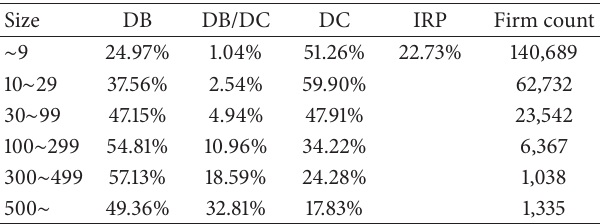
Figure 2: Ratio of firms with pension plan considering its size. Table 1: Pension plan considering firm size.